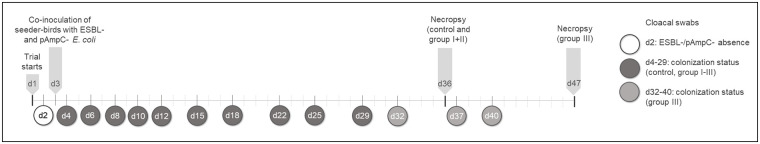
Study design of the experimental groups (control group, increased litter (I), reduced stocking density (II), and alternative breed (III)).d = day of trial.